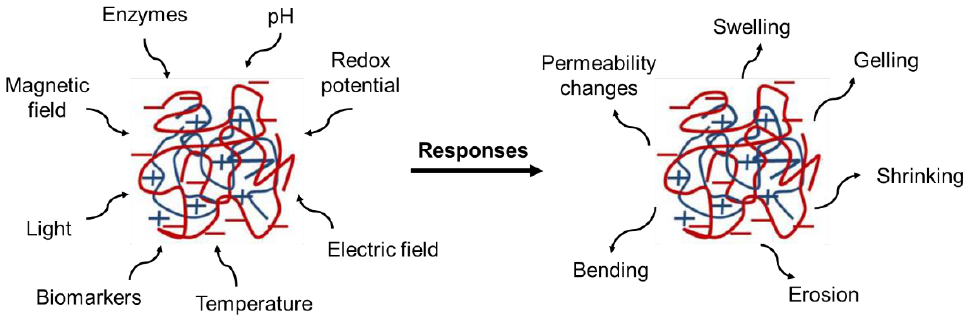
Scheme 2. Weak polyelectrolyte complexes for pharmaceutical vectorization . A schematic dia- gram of different stimuli and possible responses triggering drug delivery in weak polyelectrolyte complexes.